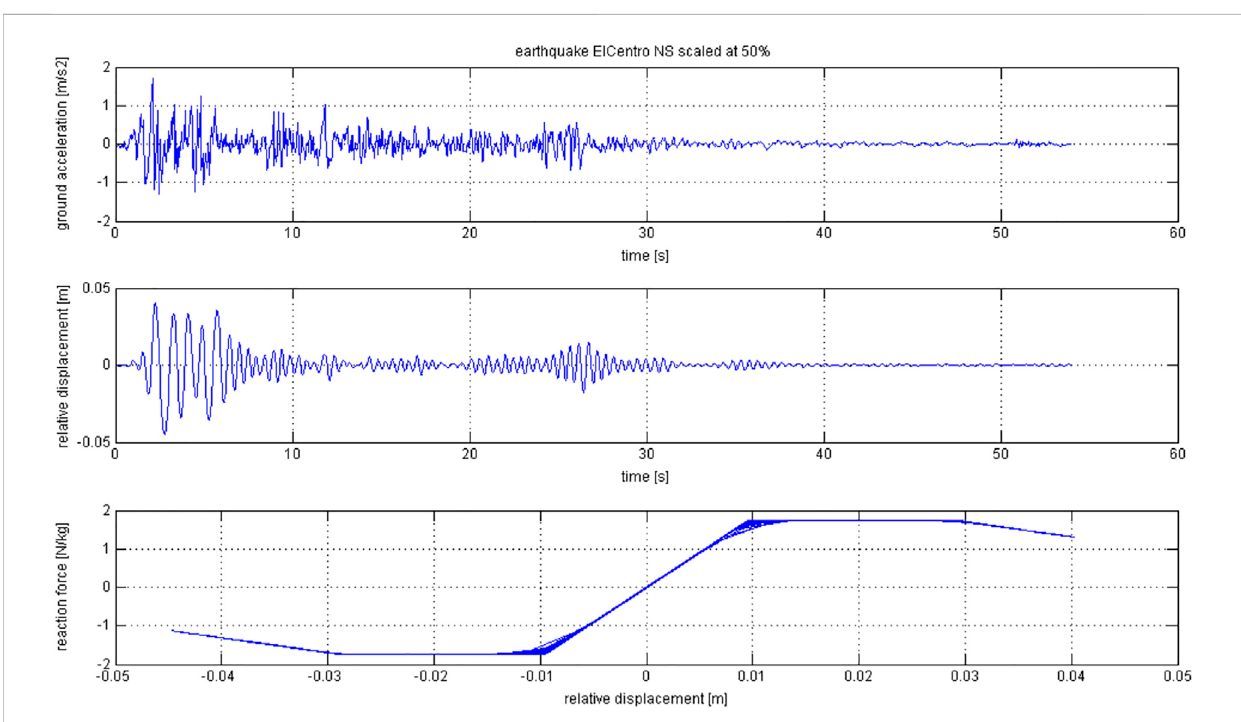
FIGURE 4 Non-linear computed response for 50% of El Centro. The peak displacement is 45 mm.